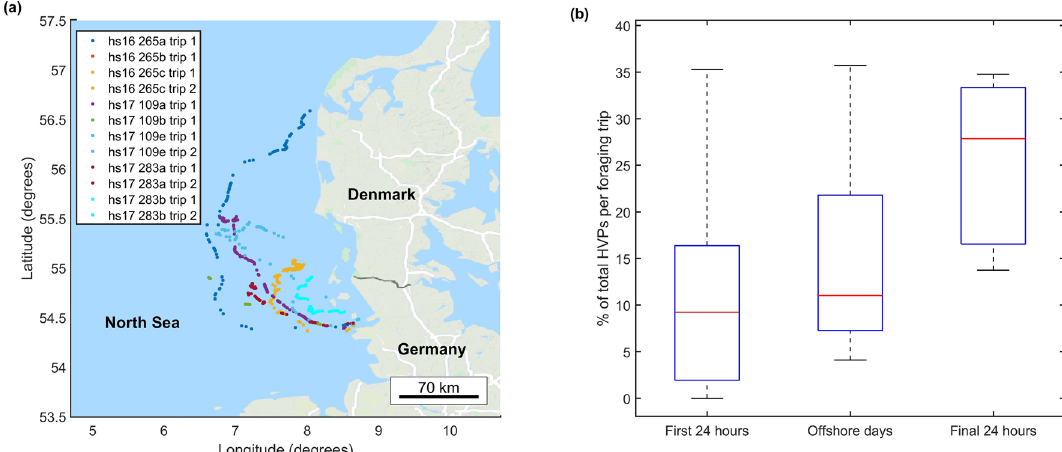
Figure 4. ( a ) Map showing the geographic location of potential high value prey captures (HVPs, i.e., a jerk transient occurring at the end of an atypically short dive). These events are not restricted to offshore sites but appear to occur across the foraging range. Map was generated in Matlab R2016a (http:// www. mathw orks. com/) using plot_google_map version 1.5 (https:// au. mathw orks. com/ matla bcent ral/ filee xchan ge/ 27627- zohar by- plot- google- map). ( b ) % of total HVPs which occur at each stage of the foraging trip in 6 complete trips by 5 seals.